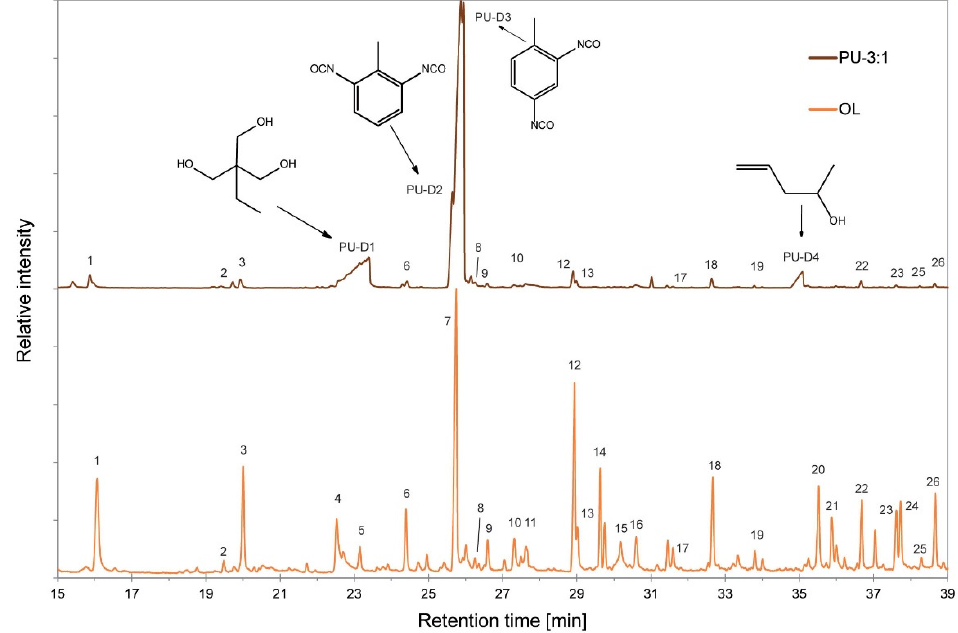
Figure 6. Pyrograms of the Organosolv lignin (OL) used and one of the produced PU sample (PU- 3:1).